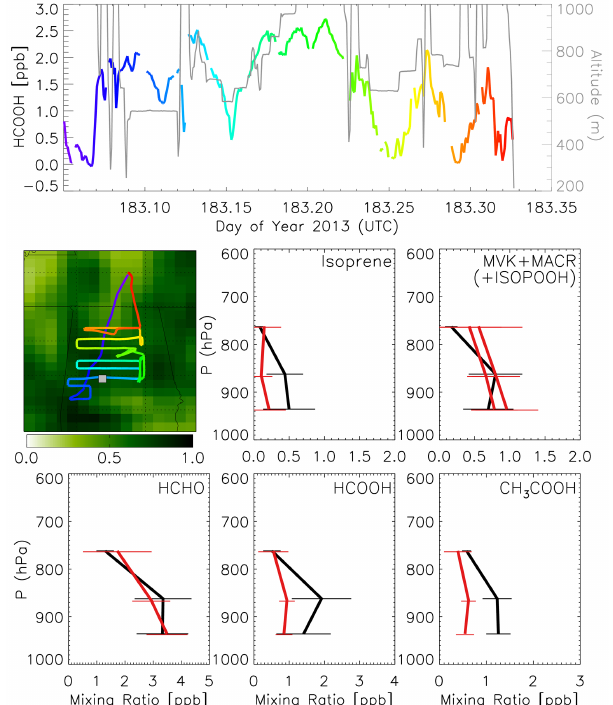
Figure 9. Diurnal amplitude of HCOOH, O x (O 3 + NO 2 ) and MVK + MACR during SOAS. Left column: mean diurnal cycle of these species as measured (black) and modeled (red) over the course of the campaign. Right column: comparison of the mean modeled versus measured nighttime (19:00–06:00LST) decay rates for the same species, plotted on a logarithmic scale. Numbers inset give the major axis slope with 95% confidence